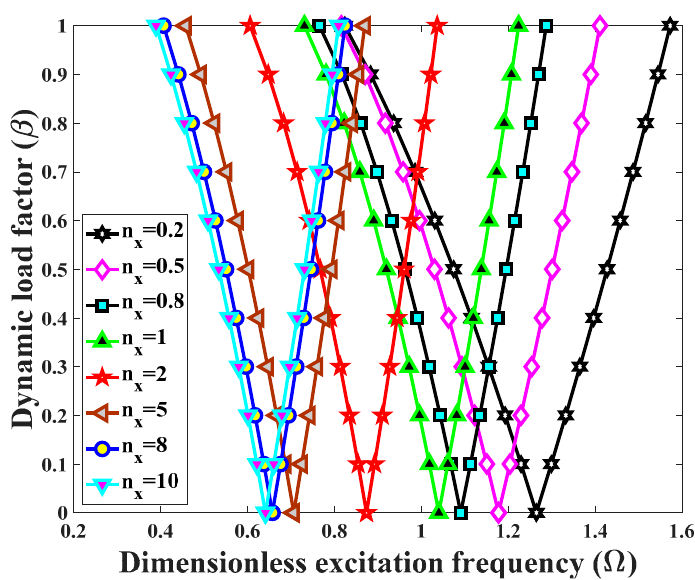
Figure 7. Effect of the longitudinal power index on the DIR for a FG cylindrical shell with Figure 7. E ff ect of the longitudinal power index on the DIR for a FG cylindrical shell with R = 0.5 m, h / R = 0.02, L / R = 1, n z = 0, α =